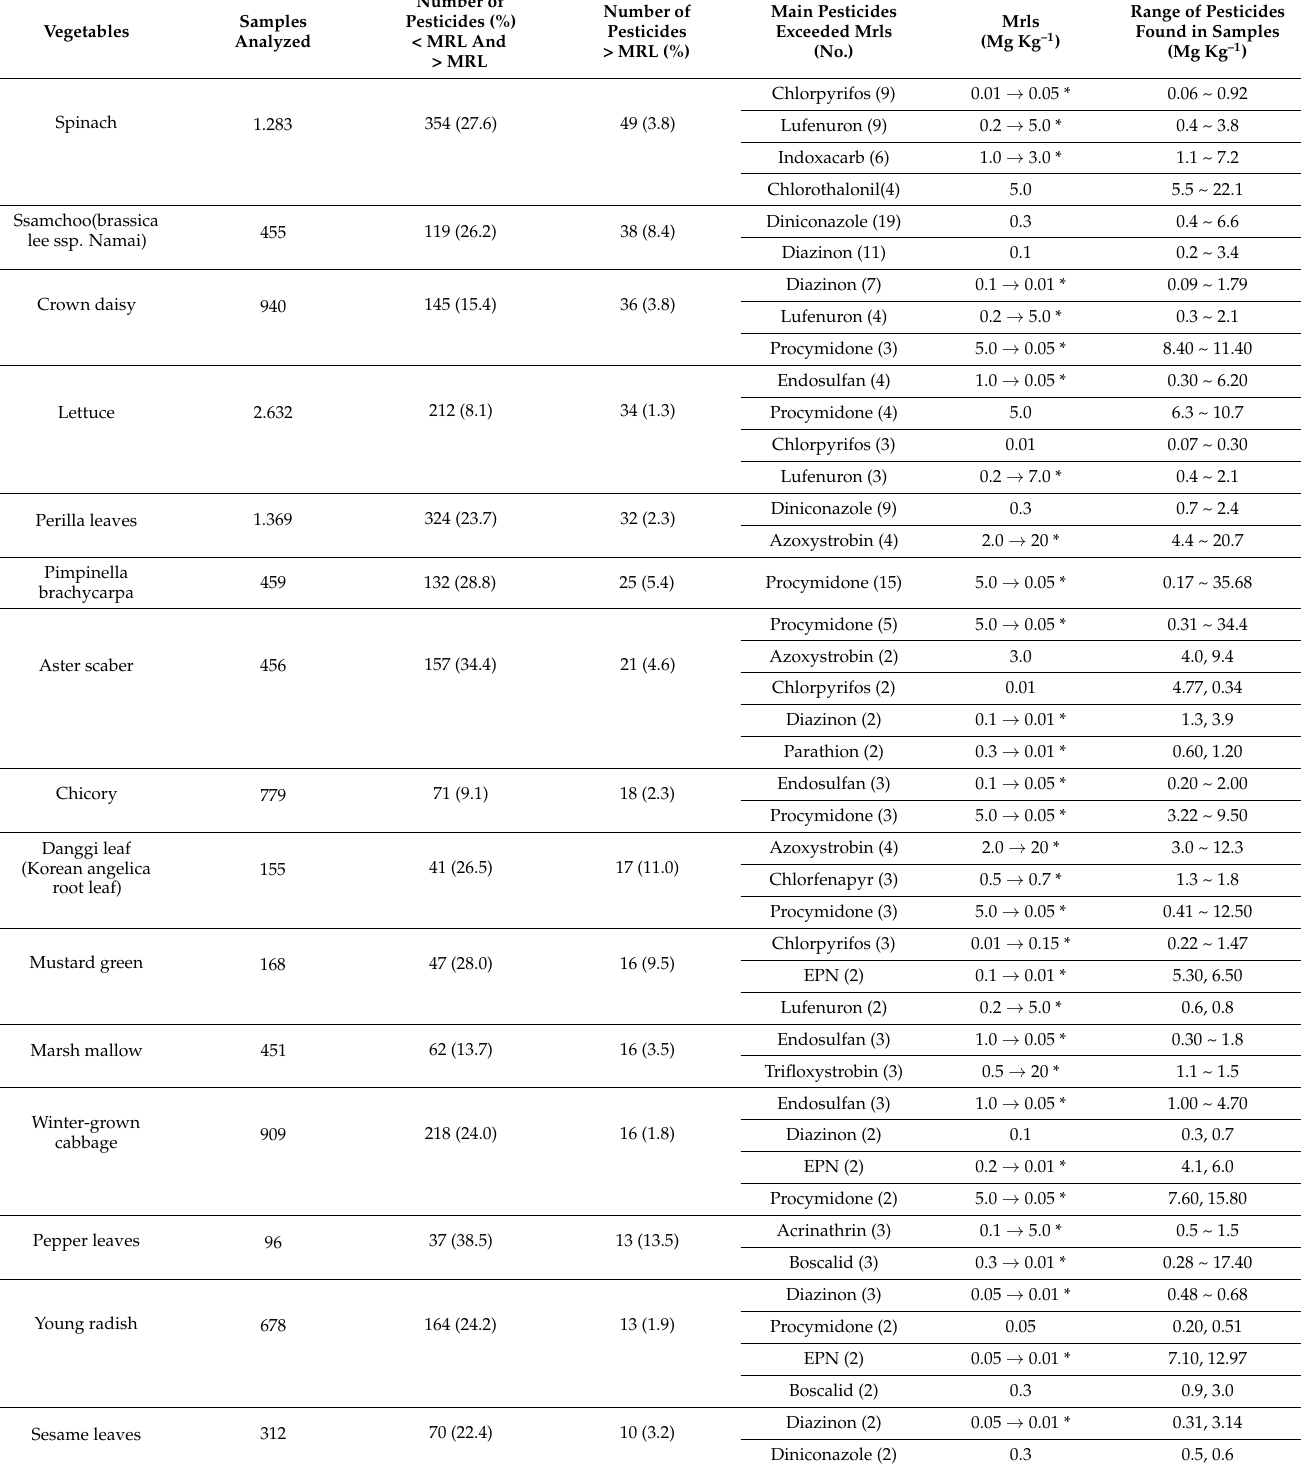
Table 5. Main pesticides detected in the 15 highest leafy vegetables exceeded MRLs in our study from 2005 to